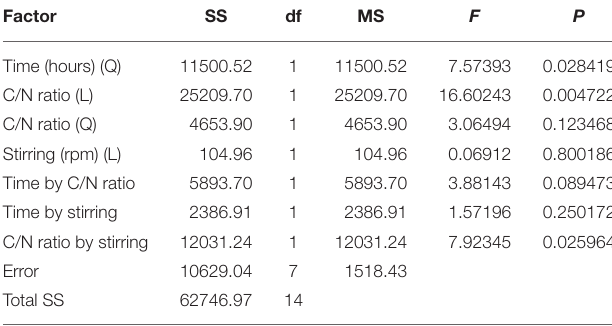
TABLE 3 | Experimental design to improve M. guilliermondii BI281 lipid content, and comparison of observed data, data predicted by the model and residues.